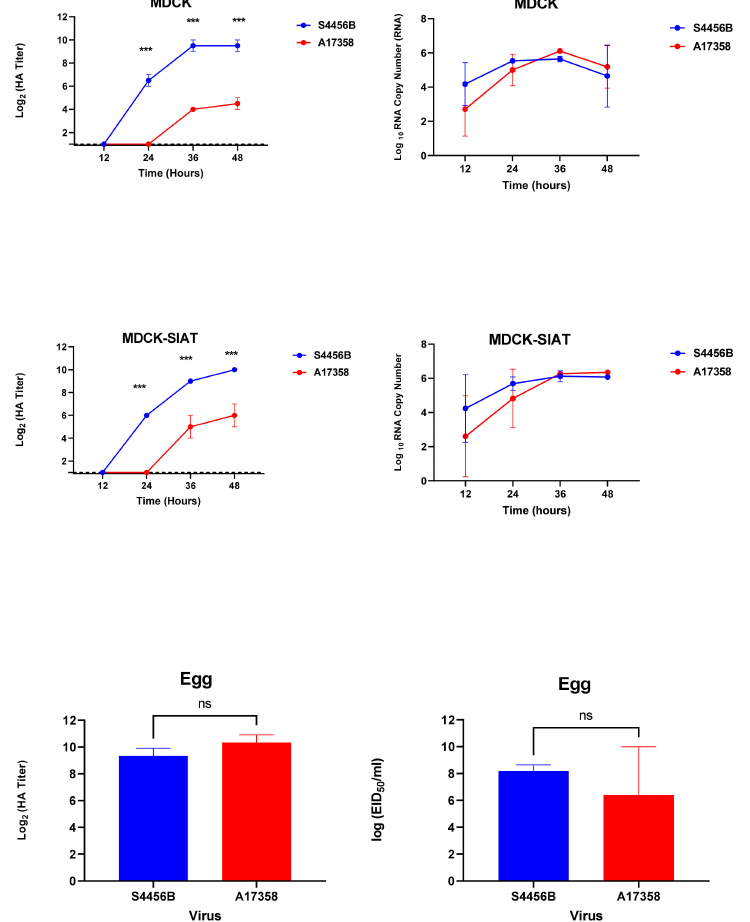
Figure 4. Growth kinetics of the two forms of Egyptian H9N2 viruses in MDCK, MDCK-SIAT, and SPF-ECEs. The cells were infected with the virus at an MOI of 0.01. At the time points indicated, the supernatant was taken and titrated by HA assay and TaqMan Real-Time PCR based on the measurement of M gene copies at different time points. The collected allantoic fluids of infected eggs with two viruses were titrated by the HA assay and EID50/mL. The significant differences are indicated (*** = p < 0.001 and non-significant =